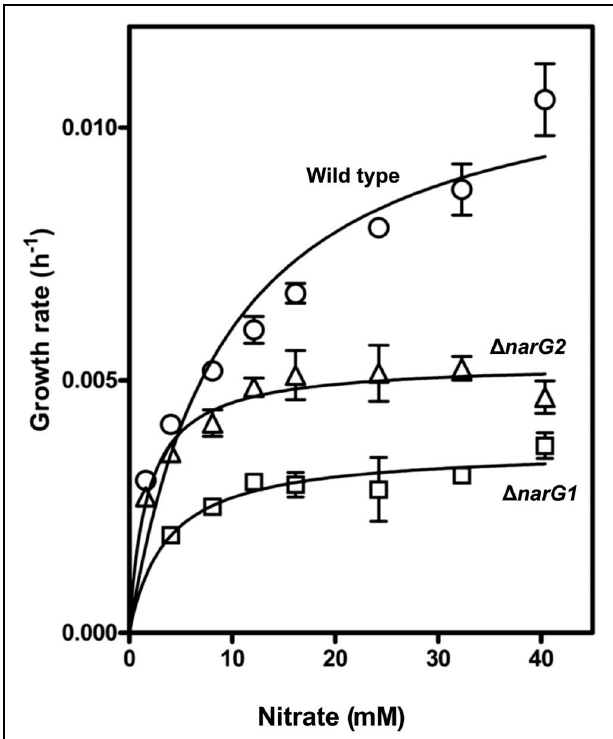
FIGURE 4 | Specific growth rates. The specific growth rates of strain JAM1 and the narG mutants were derived from triplicate cultures of the same inoculum under anaerobic conditions.